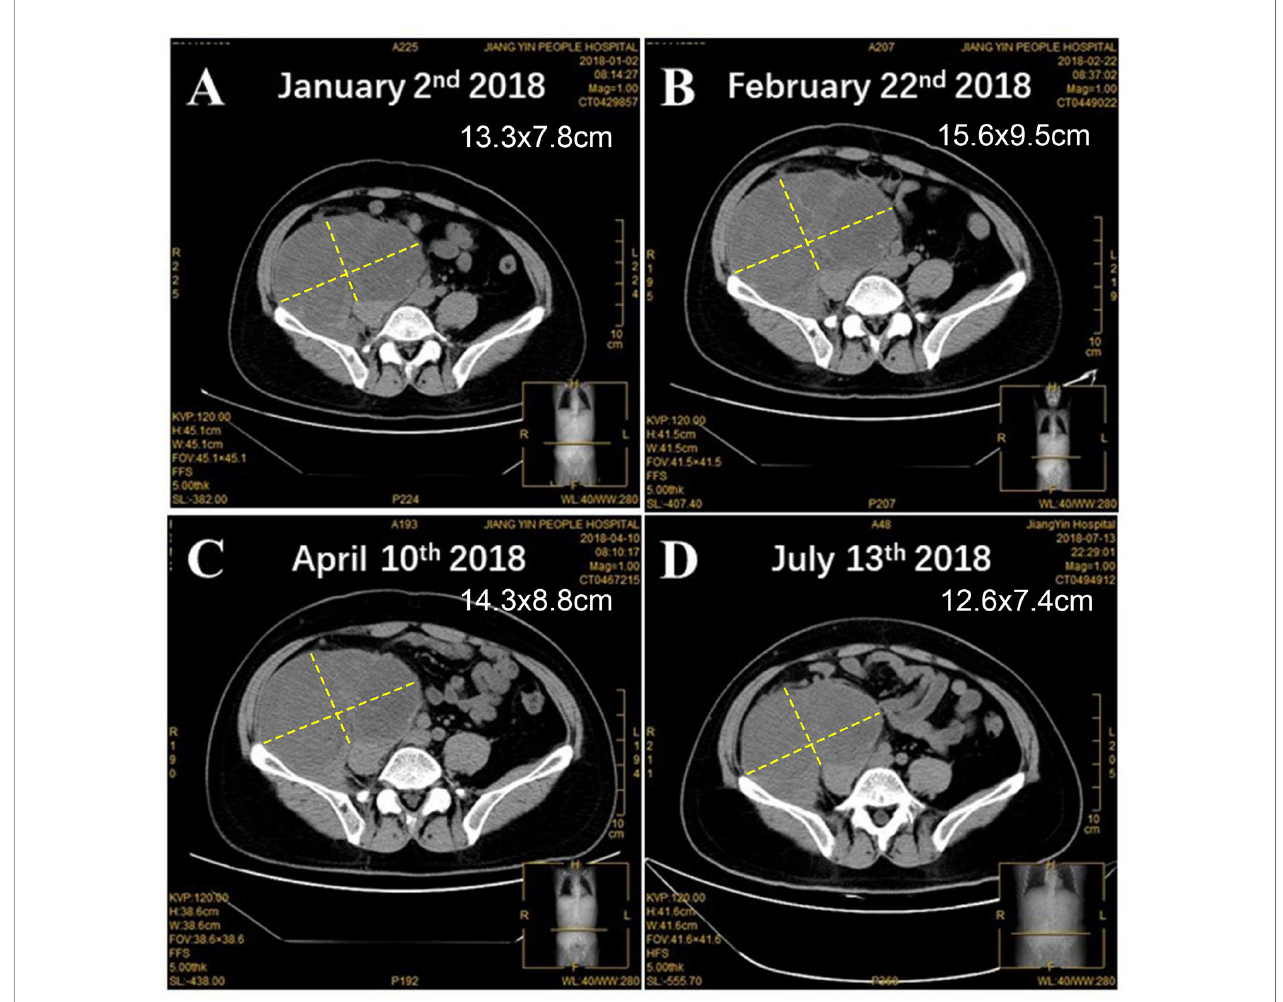
FIGURE 3 | The changes of tumor lesion. (A) Before and after the treatment of antiangiogenesis and pembrolizumab for (B) 1 month, (C) 3 months, and (D) 6